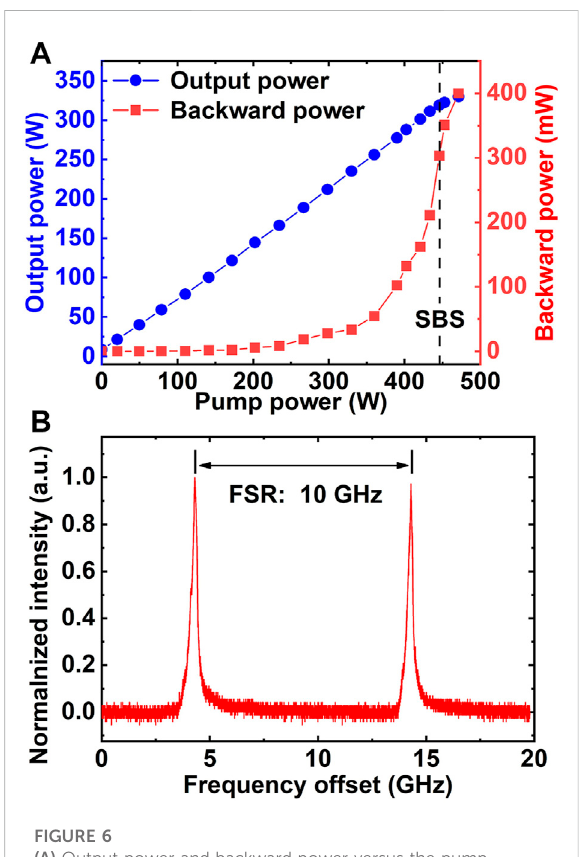
FIGURE 6 (A) Output power and backward power versus the pump power. (B) The scanning spectrum of the output